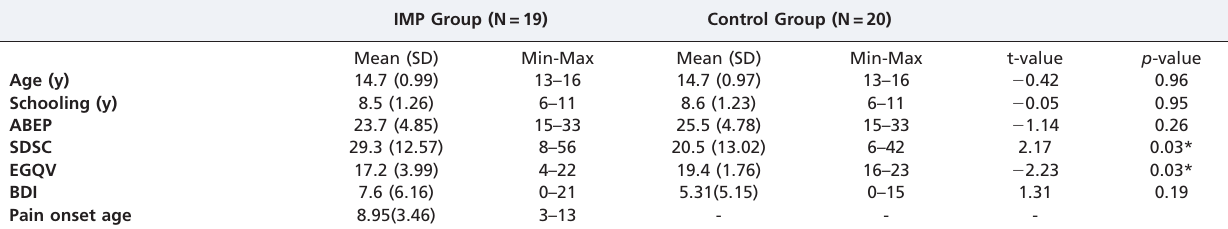
Table 1 - Demographics of and behavioral scale scores [mean ¡ (SD)] in the sample